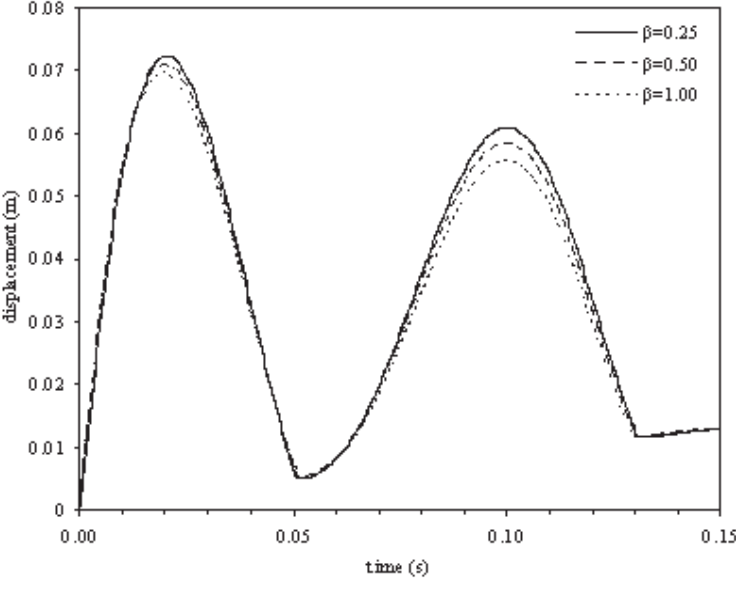
Fig. 13. Comparison of the displacement of m 1 using a 41 DOF 8th order CASE mesh with, β = 0.25, β = 0.50, and β = 1.00. of the response. Here, there is an observable difference between the CASE and FE-FCT results not seen in